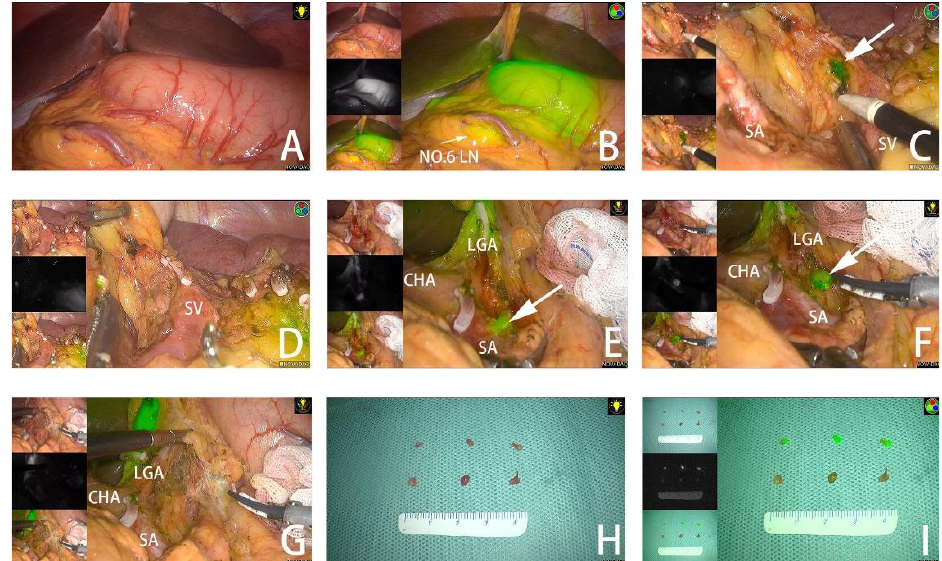
Figure 2. ( A , B ) Tumor observed under white light in fluorescent mode. ( C ) Fluorescent no. 10 LNs detected in fluorescent mode. ( D ) No remnant no. 10 LNs are found after dissection. ( E ) Fluorescent no. 11P LNs adjacent to splenic vessels. ( F ) No. 11P LNs separated from blood vessels. ( G ) No remnant No. 11P LNs are found after dissection. ( H ) LNs dissected from the specimen under white light. ( I ) LNs dissected from the specimen in fluorescent mode. The arrow points to the fluorescent LN. SA, spleen artery; SV, spleen vein; CHA, common hepatic artery; LGA, left gastric artery. Reproduced with permission [63]. Copyright 2022, Frontiers Media.